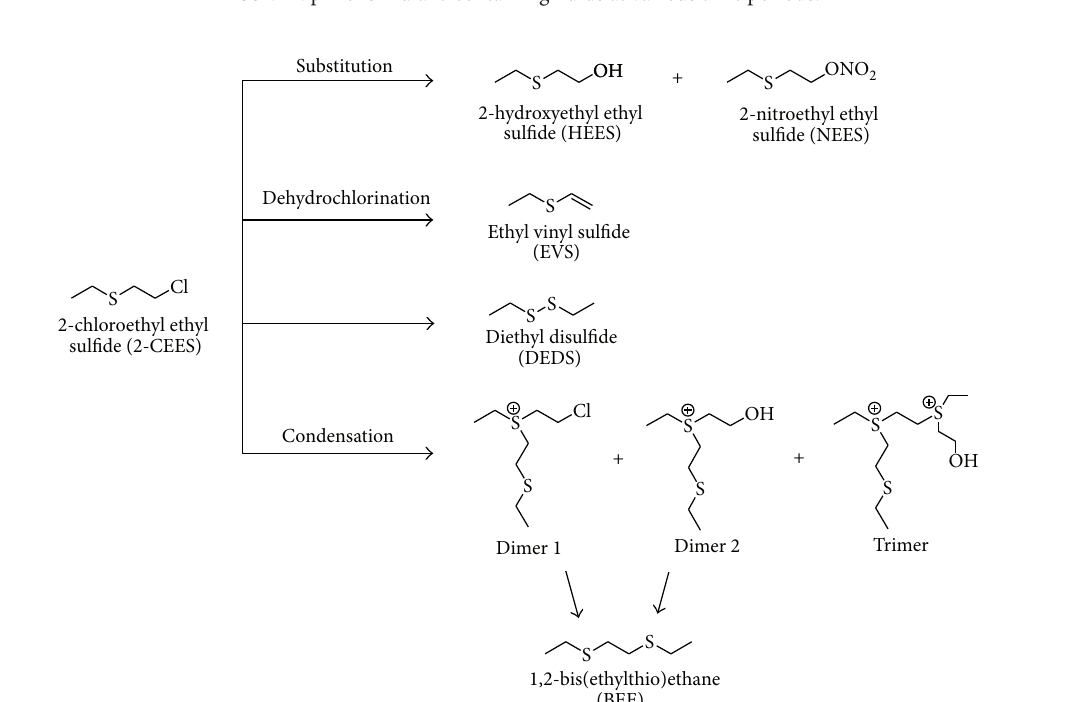
F 1: pH of simulant-containing �uids at various time periods.